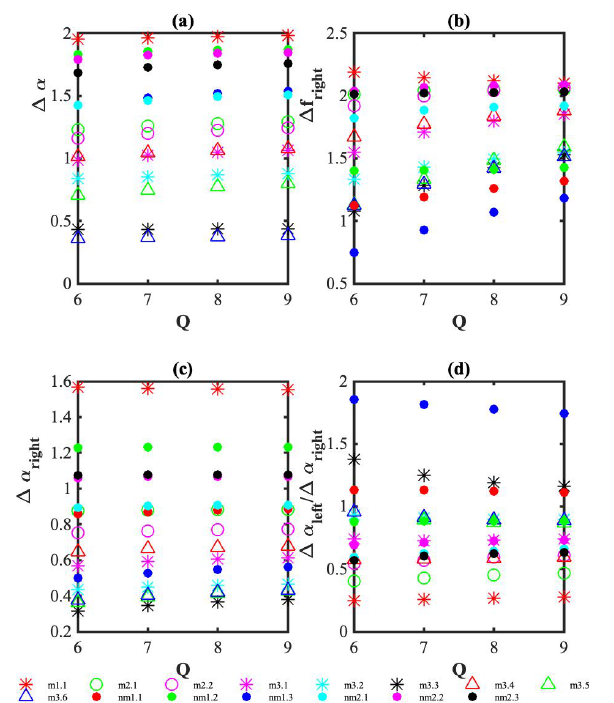
Figure A2. ( a ) ∆ α = α max α min width of multifractal spectrum. Notice that, α max = α ( Q ) and α min = α ( Q ) ; ( b ) ∆ f right , right singularity parameter characterizing the broadness of the tail to the right of multifractal spectrum; ( c ) ∆ α right = α ( q = 0 ) a ( q ) , q < 0, width of multifractal spectrum to the right; ( d ) A = ∆ α left / ∆ α right , informative descriptor of skewing the multifractal spectrum to the left or to the right. A > 1 is a spectrum skewed to the right, and A < 1 is a spectrum skewed to the right and symmetric for A =